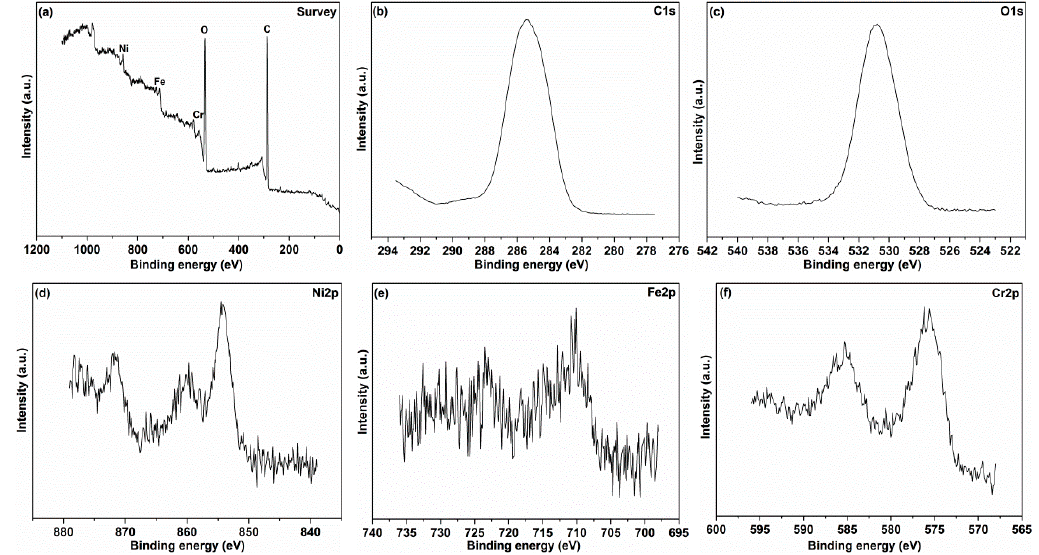
Figure 12. The XPS analysis of some elements on the worn track after friction test lubricated by pure PAO oil at 400 °C. ( a ) Survey; ( b ) C1s; ( c ) O1s; ( d ) Ni2p; ( e ) Fe2p; ( f ) Cr2p. PAO oil at 400 ◦ C. ( a ) Survey; ( b ) C1s; ( c ) O1s; ( d ) Ni2p; ( e ) Fe2p; ( f )